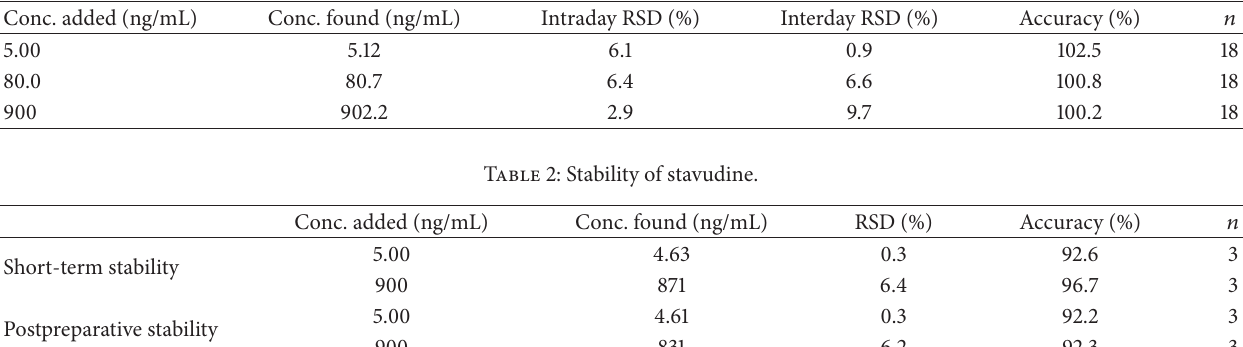
Table 1: Precision and accuracy data for the analysis of stavudine.